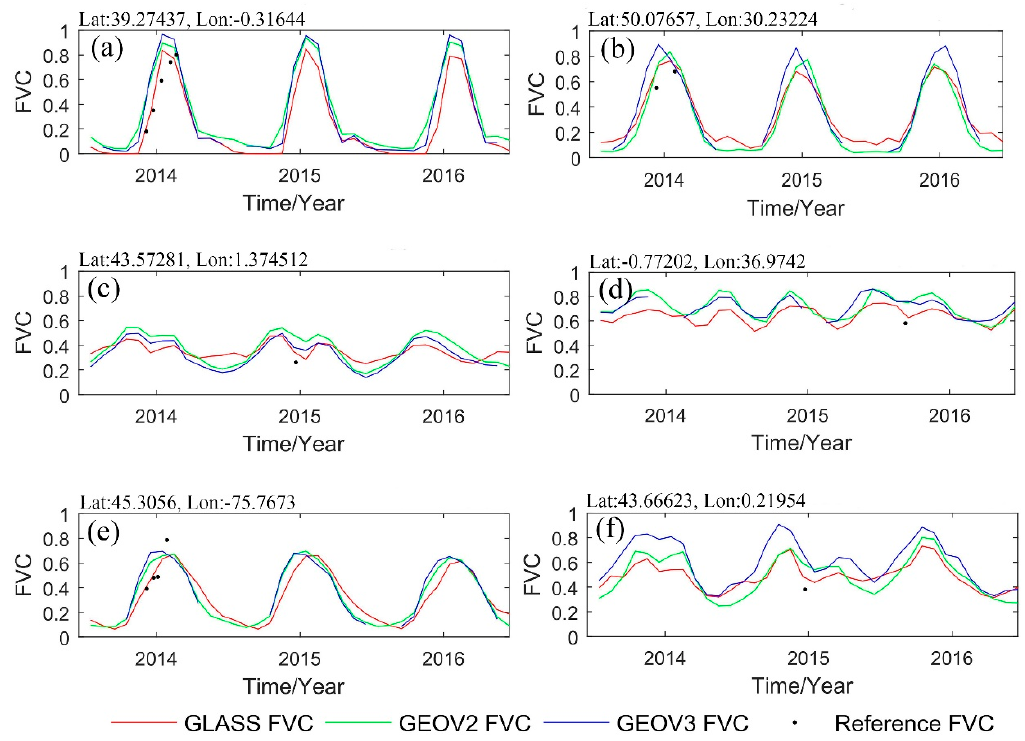
Figure 5. Temporal profiles of the GEOV2, GEOV3, and GLASS FVC products. ( a ) Rice. ( b ) Wheat, barley, corn, sunflower, and soybean. ( c ) Grass. ( d ) Tree, tea, and coffee. ( e ) Wheat, corn, and soybean. ( f ) Wheat and sunflower.